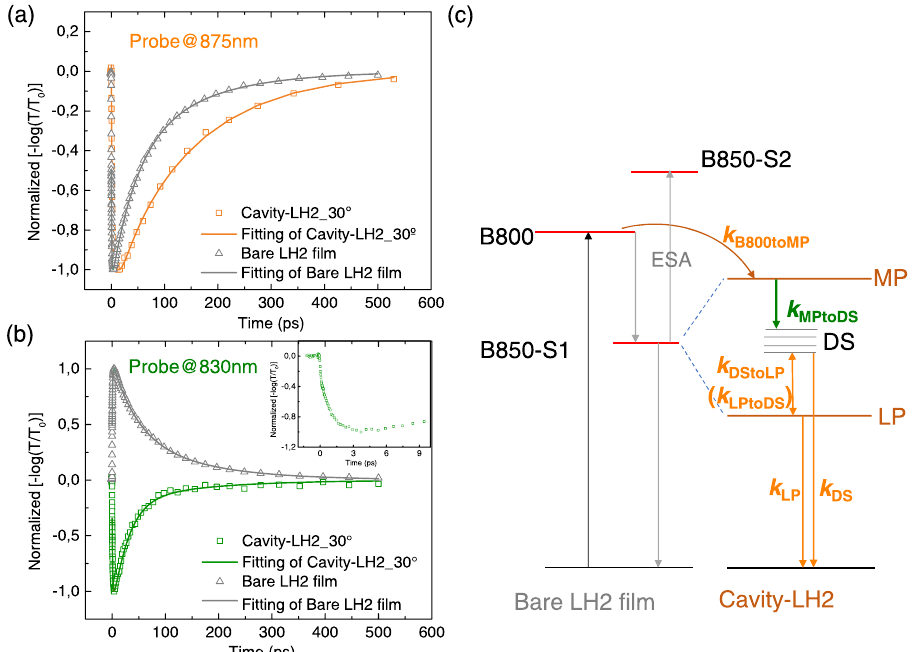
10ps) and corresponding c energy relaxation pathways. The solid lines are the fi tting results based on the rate-based kinetic